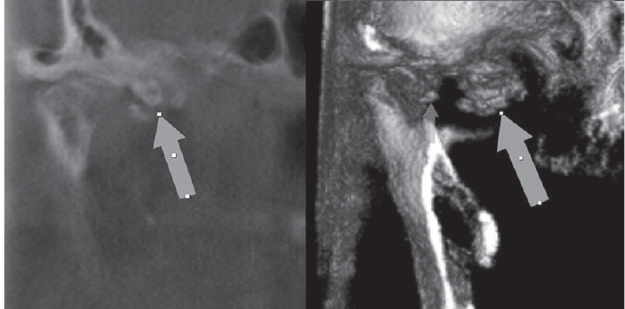
Fig. 6. Case 3. Coronal image and 3-D reconstruction (CBVT) of right TMJ. Arrows point the loose bodies and a mass medially to the condylar head originating from the temporal